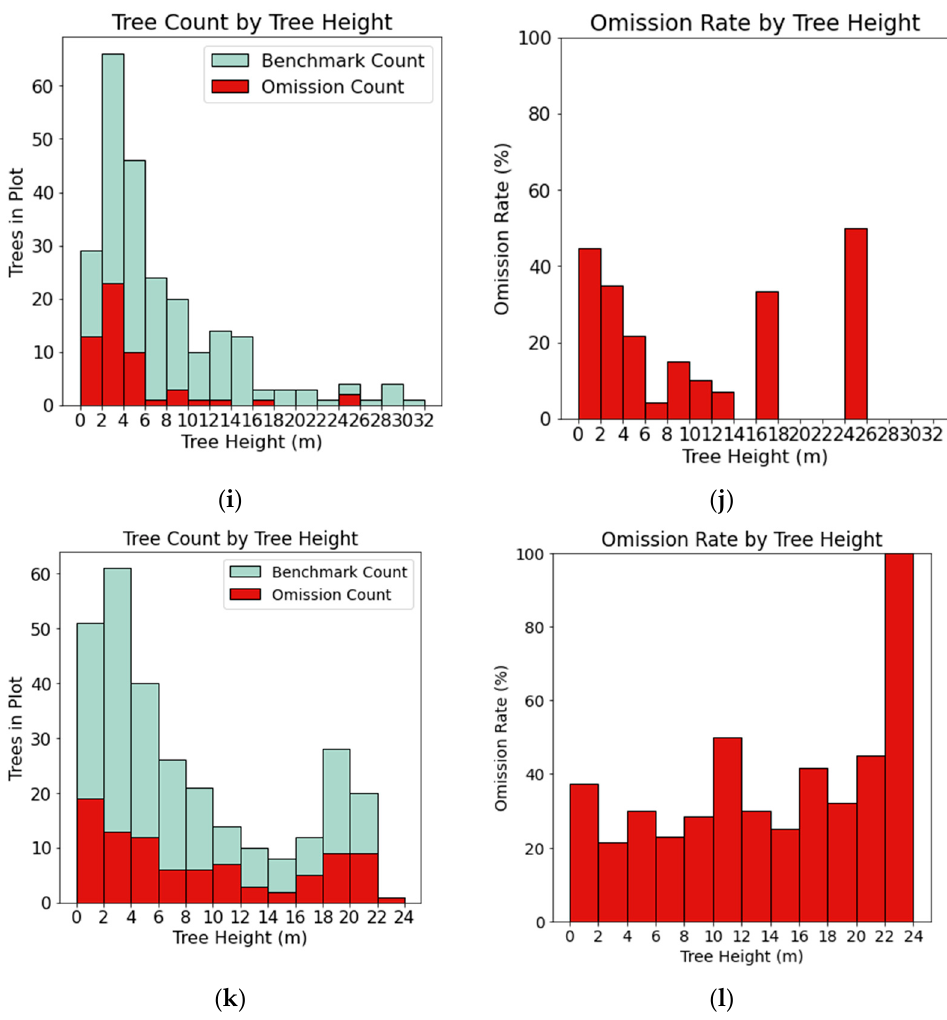
Figure A1. Omission errors for each of the 6 TLS data sets. Omission errors are aggregated by tree height. ( a , c , e , g , i , k ) show the number of omissions by tree height superimposed on the number of trees in the validation data of the same height class. ( b , d , f , h , j , l ) show the omission errors as a percentage of total trees within each height class.